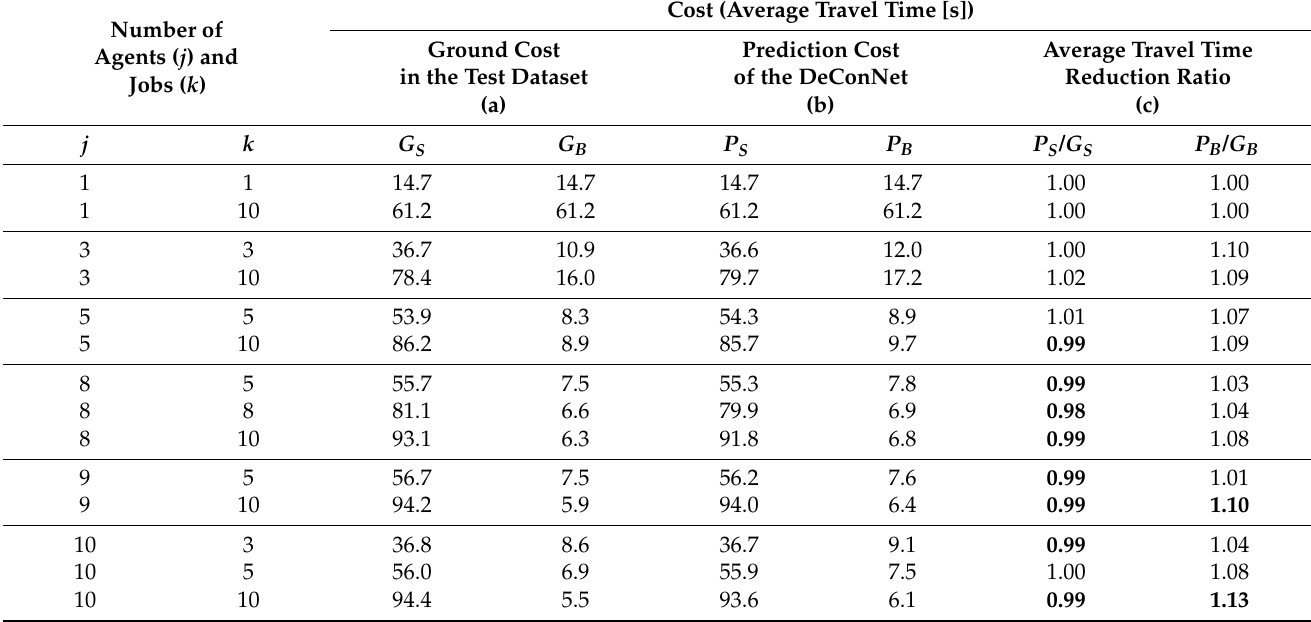
Table 4. Result of comparing the ground cost of the test dataset with the prediction cost of the